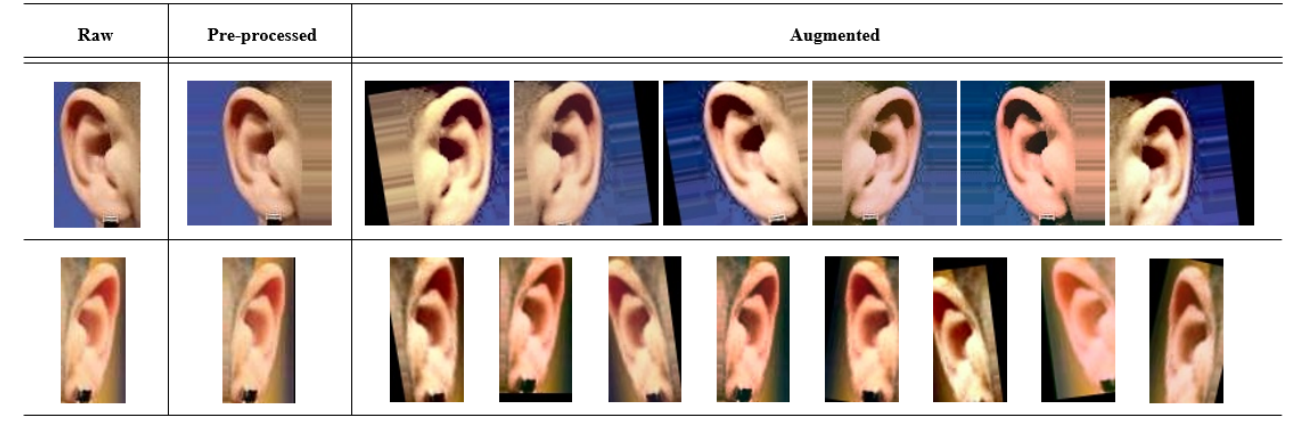
Figure 7. Preprocess and data augmentation examples. First row for the case of square input size (224 × 224), second row for the 1:2 aspect ratio (112 ×